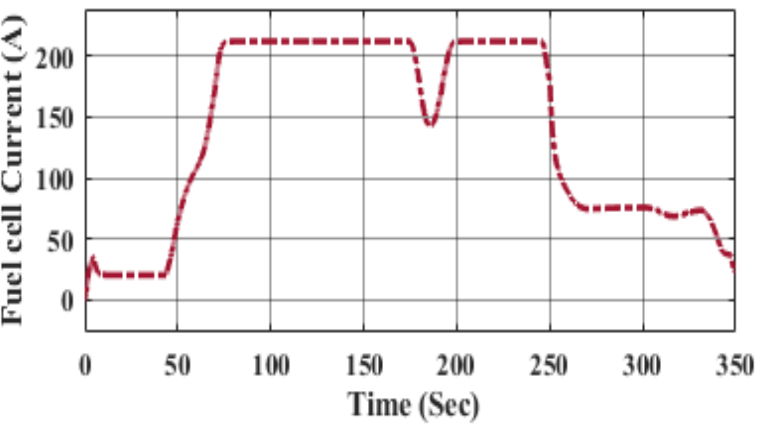
Figure 19. Variation in fuel cell input current.